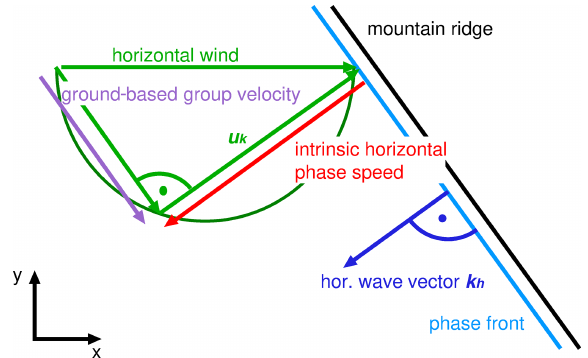
Figure A1. Schematic view of the horizontal propagation of a mountain wave. For details, see the